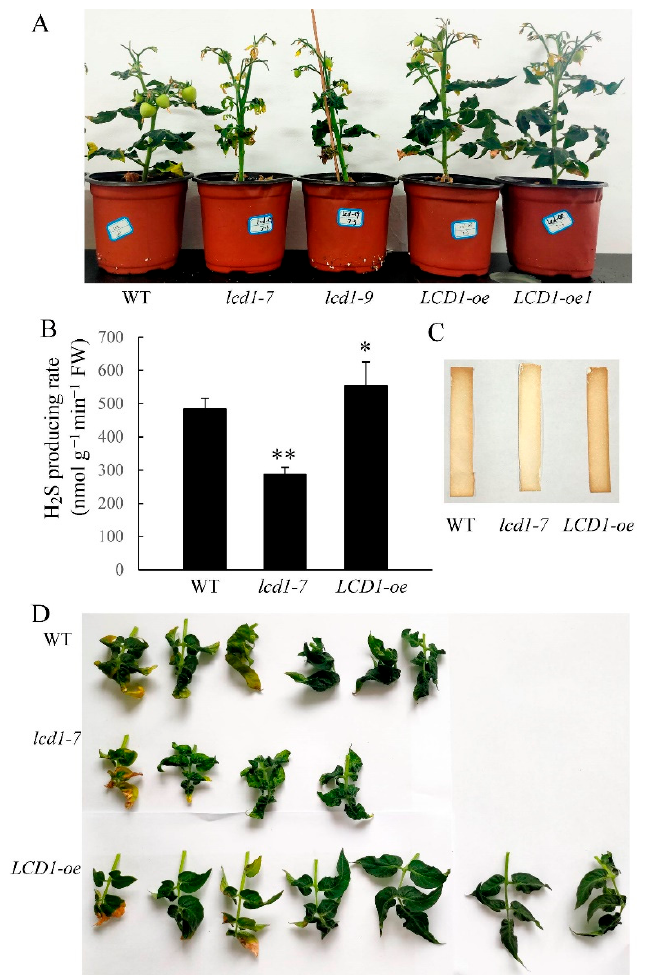
Figure 1. Phenotypic characterization of lcd1 mutants and LCD-oe (over-expression) tomatoes. ( A ) Phenotype of 10-week-old wild-type (WT), lcd1-7 , lcd1-9 , LCD1-oe , and LCD1-oe1 plants. ( B ) H 2 S producing rate in the mature leaves from wild type, lcd1 , and LCD1-oe lines of 10 weeks growth. ( C ) H 2 S production from the mature leaves of 10-week-old wild type, lcd1 , and LCD1-oe lines detected by lead acetate H 2 S detection strips (Sigma-Aldrich). ( D ) The leaves of different tomato lines in ( A ) were detached and photographed. Data are means of three biological replicates ± standard deviation (SD). The symbols * and ** stand for p < 0.05 and p < 0.01 as determined by the Student’s t -test, respectively.